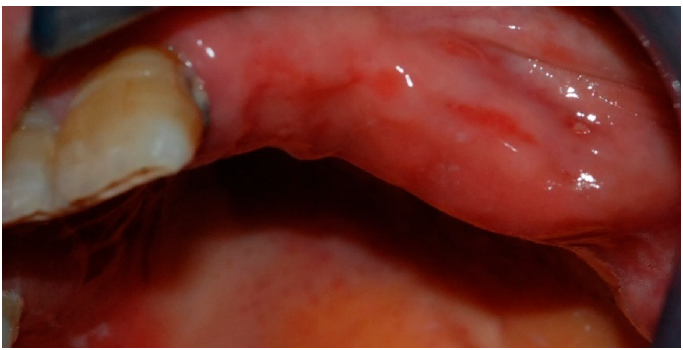
Figure 4. Inflamed gingival tissue at the upper-left maxillary region.